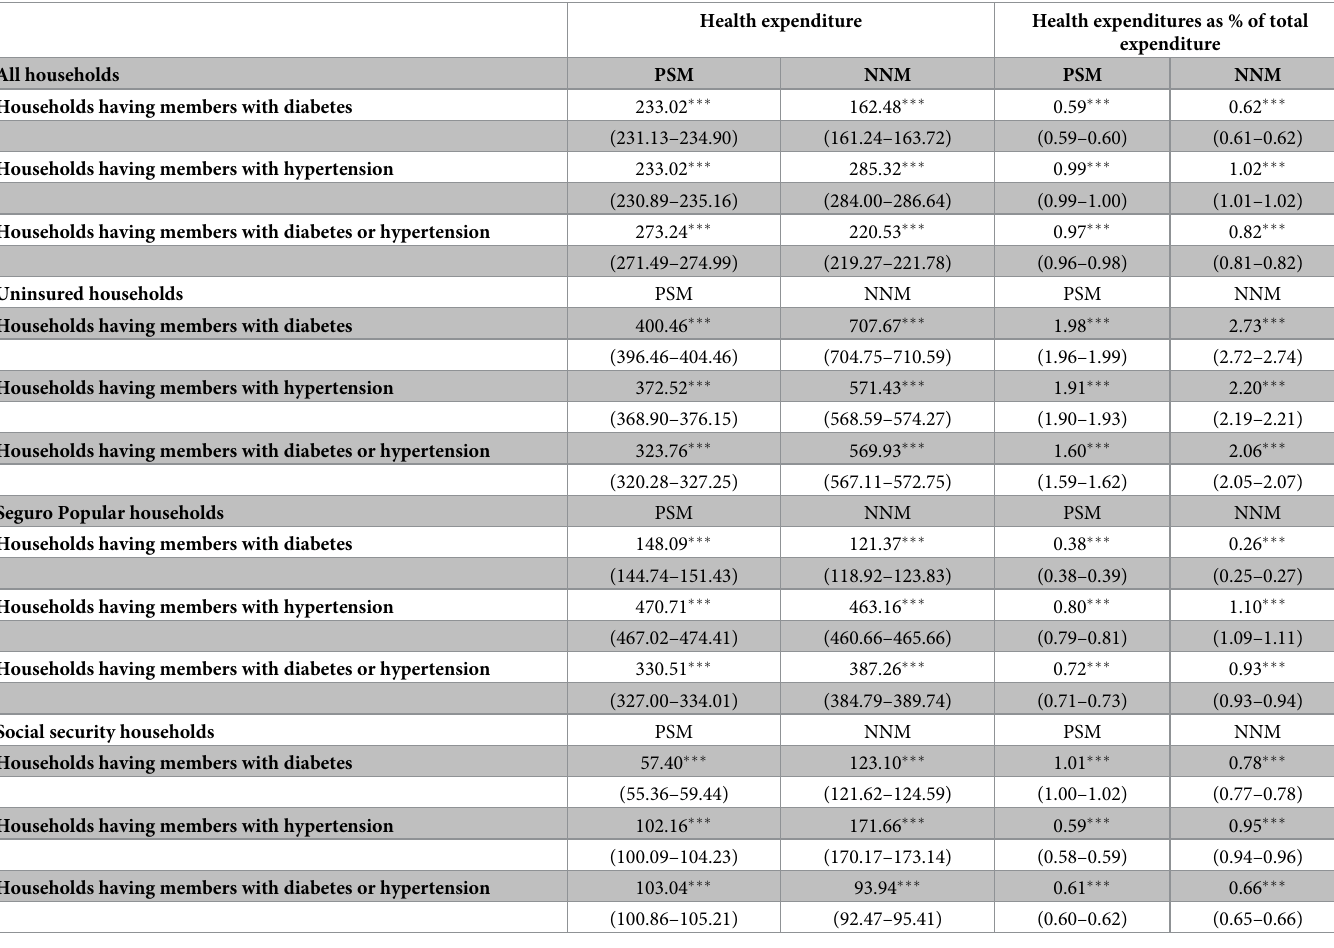
Table 3. Difference (95% confidence interval) in total expenditure and percentage of total household health among Mexican households having a member with diagnosed diabetes or hypertension matched with households without such